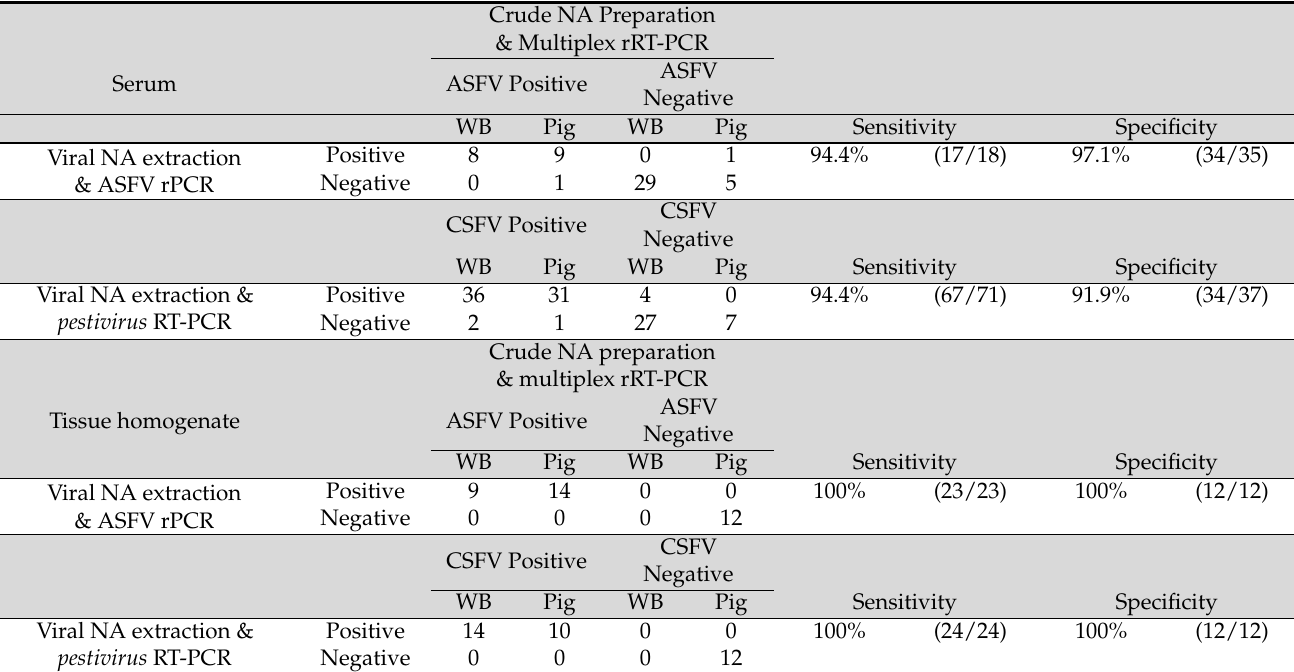
Table 3. Validation study for clinical samples from wild boars of the simple and multiplex real-time RT-PCR system for ASFV and